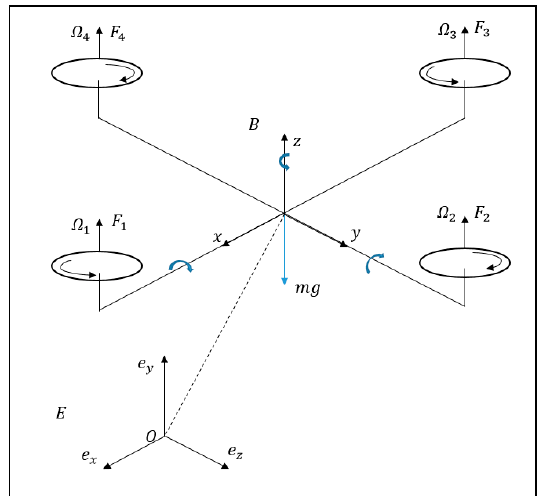
Figure 1. Quadcopter configuration.